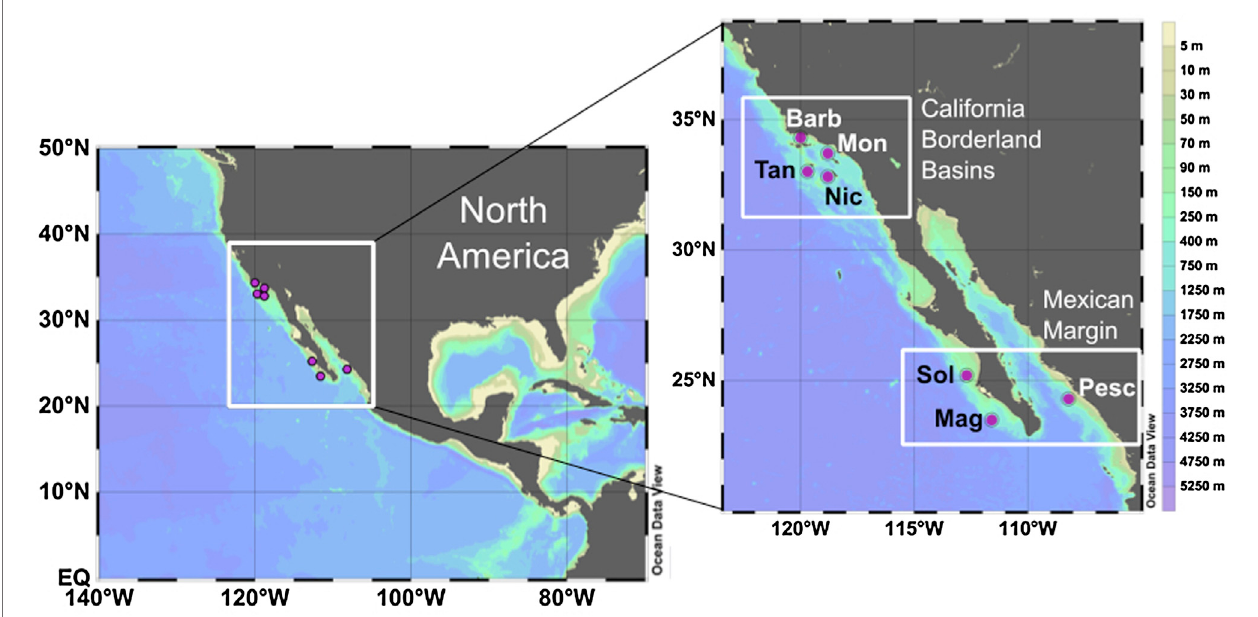
FIGURE 1 | Locations of the sites studied on the northeastern Paci fi c margin of North America. Enlarged map shows the California Borderland Basins (Barb — Santa Barbara, Mon — Santa Monica, Nic — San Nicolas, Tan — Tanner Basin) and the Mexican Margin sites (Sol - Soledad Basin, Pesc — Pescadero